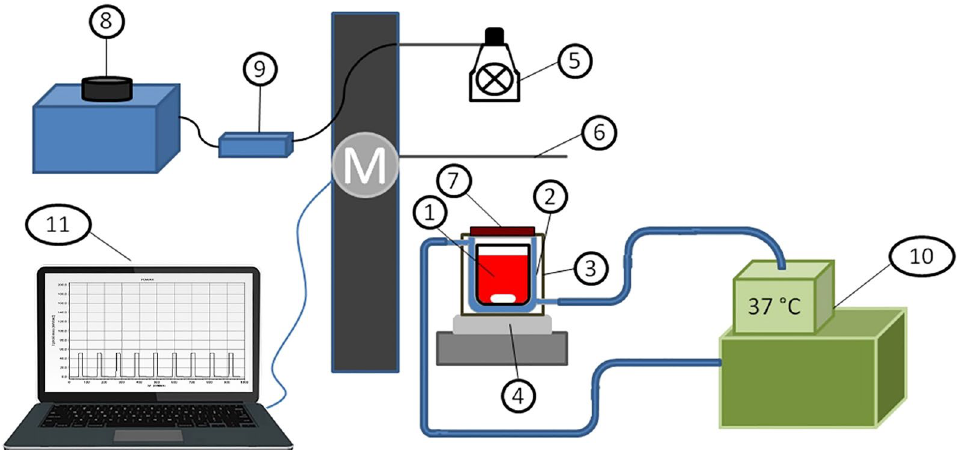
Figure 1. Diagram of the system for PBM of blood with NIR radiation, where: 1—blood with a magnetic bar are placed in a polypropylene container, 2—water-jacketed glass chamber, 3—external housing, 4—the electromagnetic stirrer, 5—halogen reflector, 6—moving shutter, 7—NIR filter, 8—autotransformer, 9— switched-mode power supply, 10—thermostat, 11—a computer with an application controlling the operation of the motor ‘M’ responsible for opening the shutter during pulsed